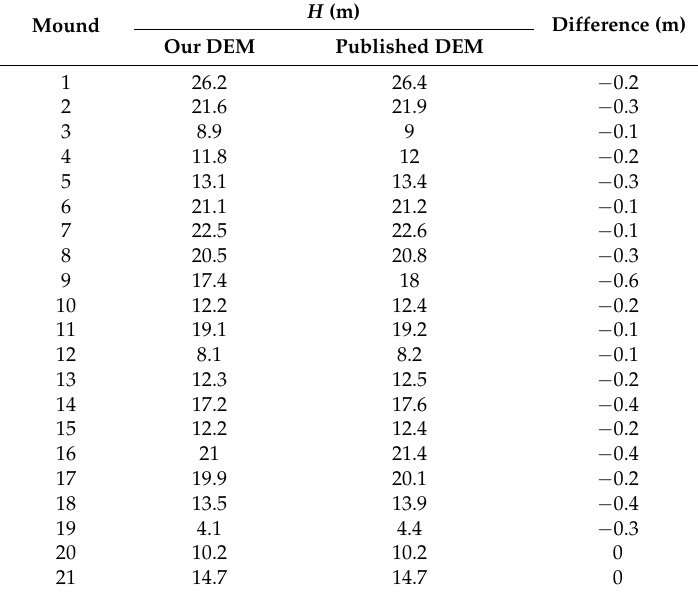
Table 3. Comparisons of morphometric parameters of 21 measured mounds extracted from both our ASP-derived DEM (Figure S9) and a SOCET SET-derived DEM (Figure S41). H (m) Difference (m) Mound Our